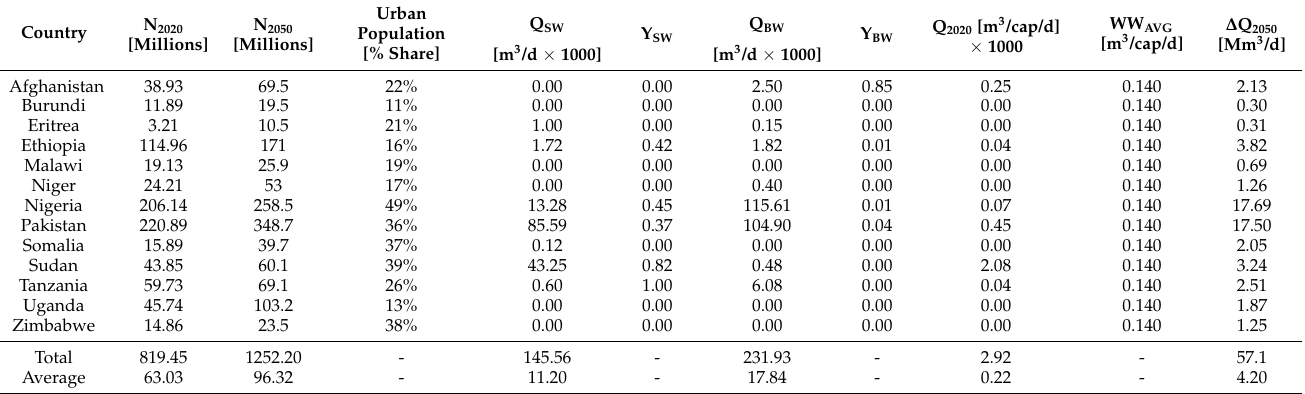
Table 3. The current installed and projected desalination capacity for sea and brackish water desali- nation plants, m 3 /d, in the selected water-scarce countries.